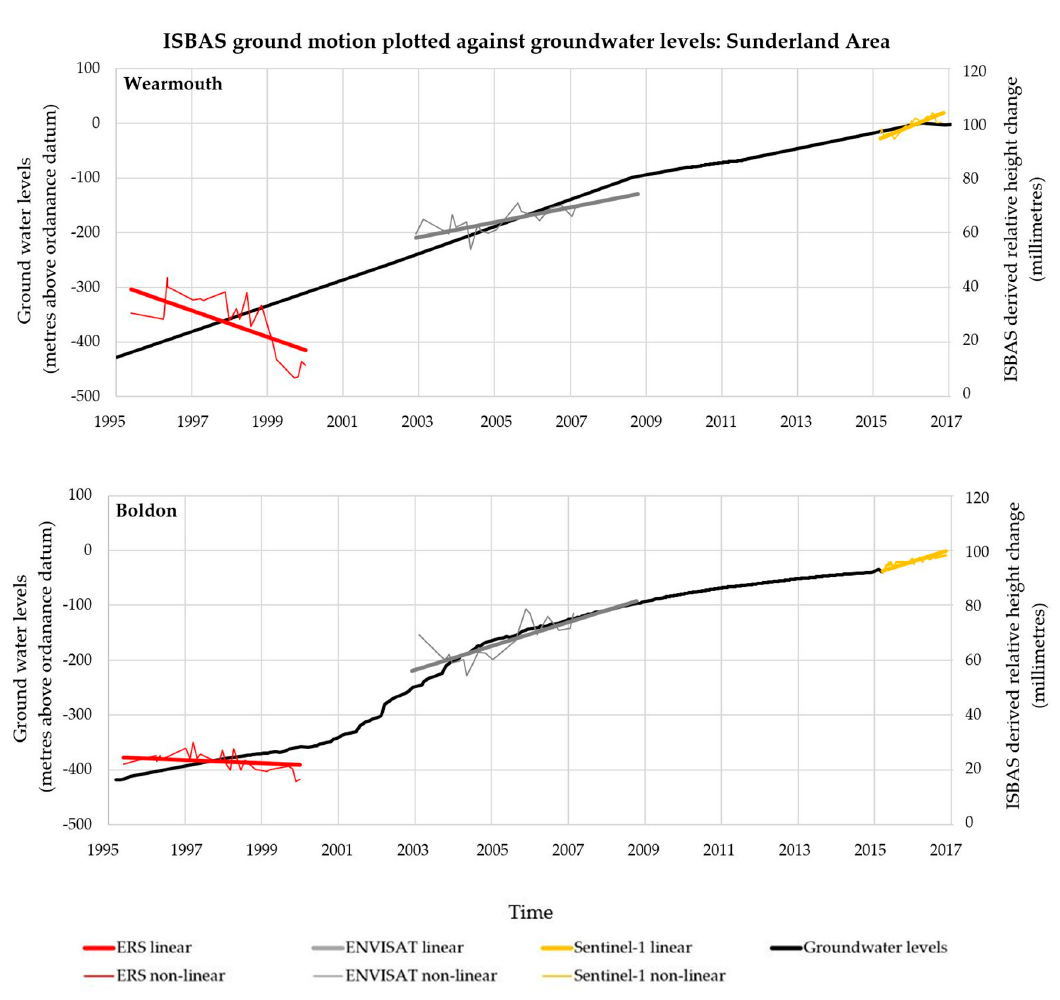
Figure 10. Groundwater levels plotted against neighbouring ISBAS time-series and linear velocities (derived separately) at Wearmouth and Boldon, the locations of which are marked on Figure 8.